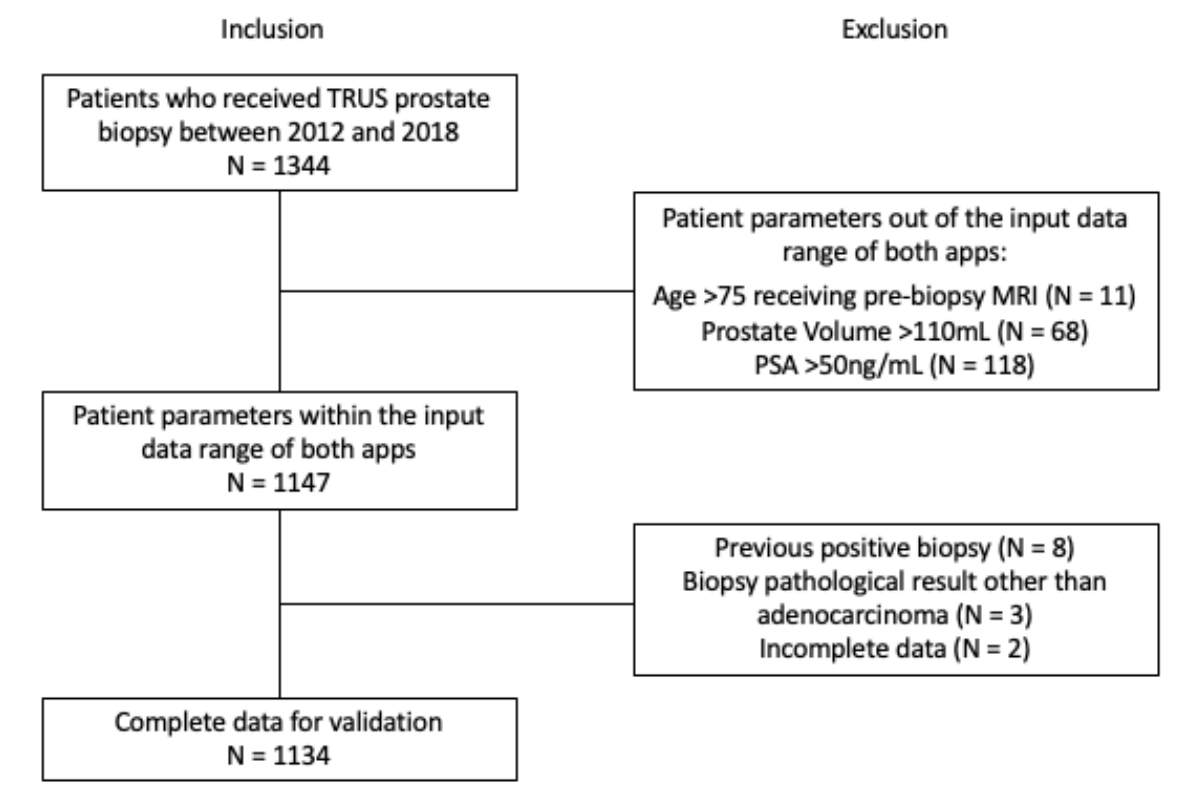
Figure 1. Flowchart of patient enrollment into the study. MRI: magnetic resonance imaging; PSA: prostate-specific antigen; TRUS: transrectal